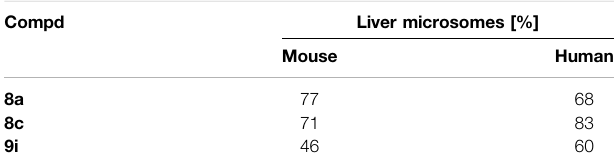
TABLE 3 | Stability of selected hybrids 8a,c and 9i in mouse and human microsomes. Compd Liver microsomes [%] Mouse